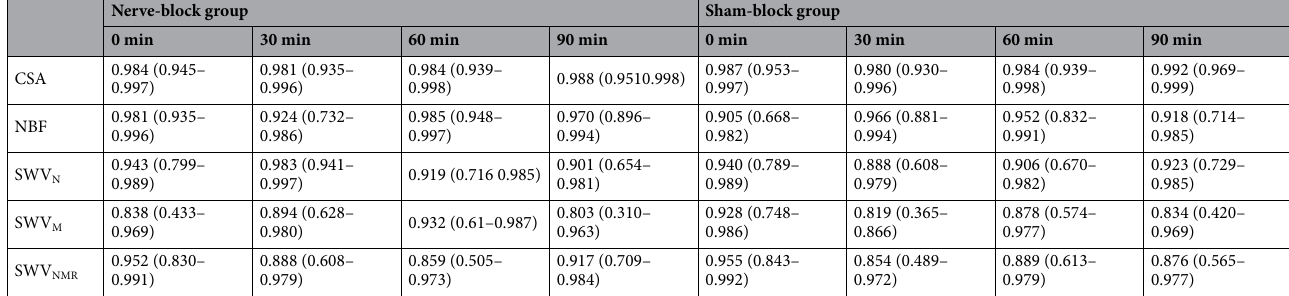
Table 2. Intra-rater reliability of the US parameters. Values represent intra-class correlation coefficient (ICC). Numbers in parentheses are 95% confidence Intervals. ICC (1,1) was used for intra-rater reliability. CSA cross- sectional area, NBF nerve blood flow, SWV N shear wave velocity of the sciatic nerve, SWV M shear wave velocity of the muscle, SWV NMR the ratio of shear wave velocity of the nerve to